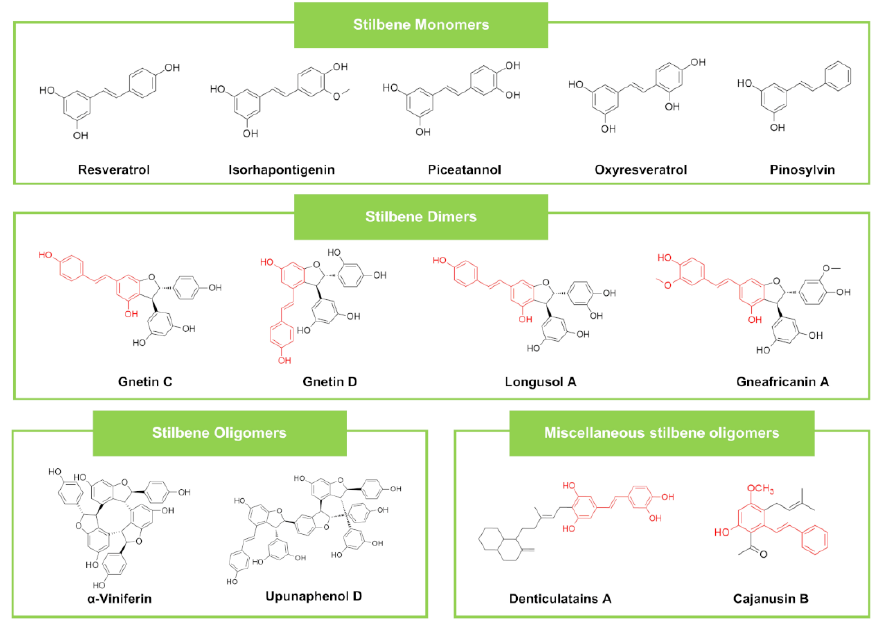
Figure 5. Representative chemical structures of different classes of stilbene and nature-derived stilbenes.